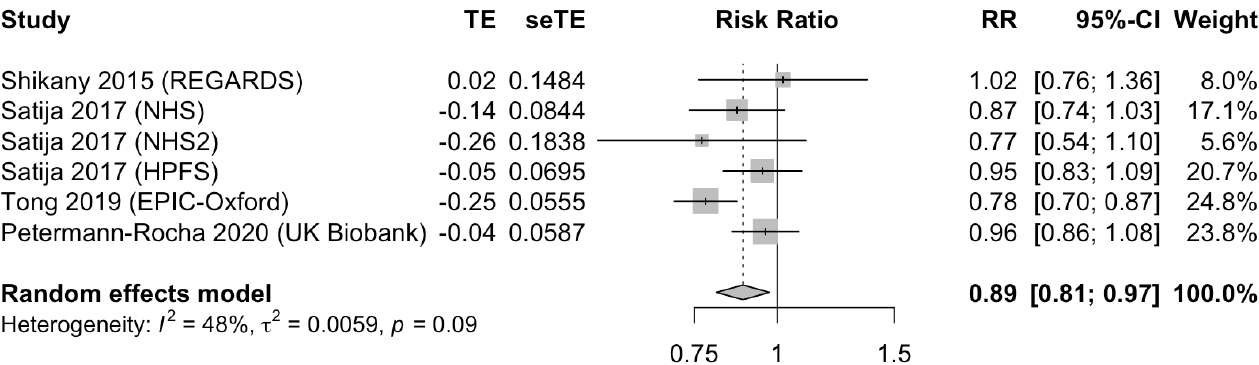
Figure 3. Forest plot of the adjusted relative risk (RR) of coronary heart disease for the highest versus the lowest adherence to plant-based dietary patterns. Pooled risk estimates and 95% confidence intervals (CI) using a random effects model for meta-analysis are in bold. Abbreviations: CI, confidence interval; EPIC, European Prospective Investigation into Cancer and Nutrition; NHS, Nurses’ Health Study, NHS2, Nurses’ Health Study II; REGARDS, Reasons for Geographic and Racial Differences in Stroke; RR, relative risk; seTE, standard error of treatment effect; TE, treatment effect; UK, United Kingdom.